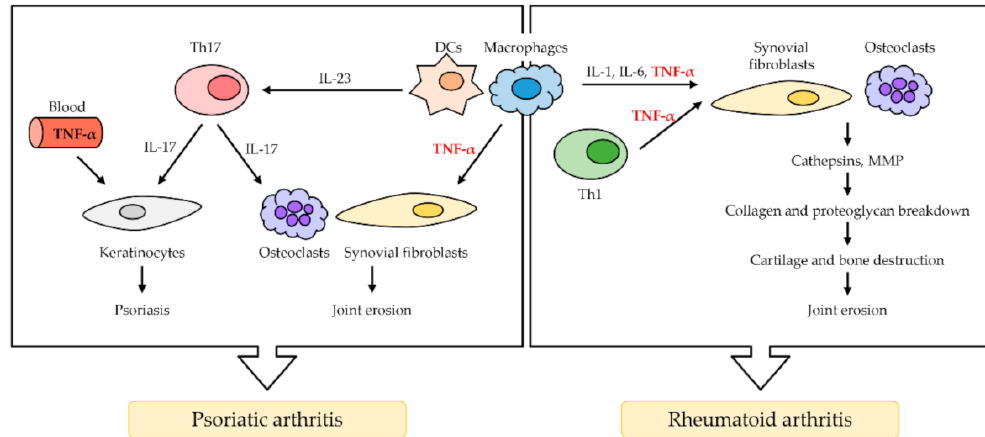
Figure 2. The role of TNF- α in rheumatoid arthritis (RA) and psoriatic arthritis (PsA). TNF- α is mainly secreted by macrophage and Th1 cells. In RA, TNF- α activates synovial fibroblasts, which causes the overproduction of cathepsins and MMP. The breakdown of collagen and proteoglycan follows, resulting in cartilage and bone destruction, as well as joint erosion. Osteoclasts in RA induce synovial hyperplasia and angiogenesis. In PsA, activated dendritic cells (DCs) and macrophages secrete TNF- α and IL-23 excessively. IL-23 induces T cells to differentiate in Th17 cells, which secretes IL-17. IL-17 and TNF- α in the blood activate keratinocytes, resulting in psoriasis (PS). TNF- α also activates osteoclasts, leading to synovial fibroblast, which results in joint